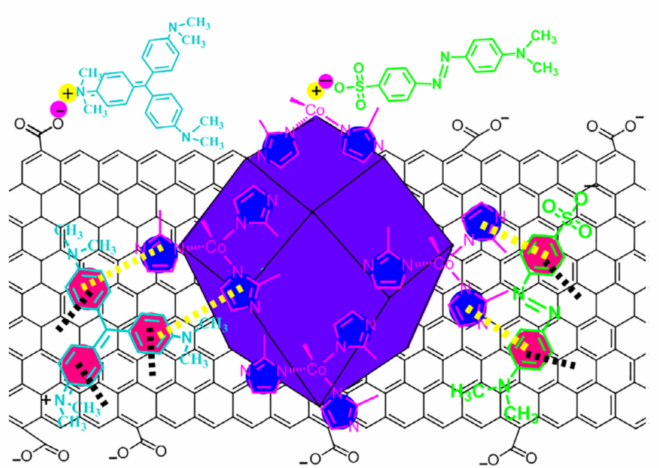
Figure 18. π - π Interactions and electrostatic interaction between the 3D ZIF-67-rGO composite aerogel and dyes. Reprinted with permission from [331].